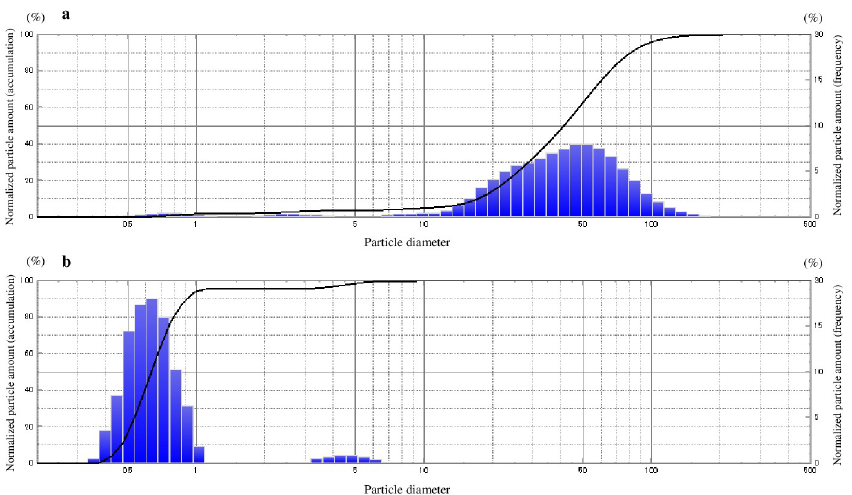
Fig 2. Measurement of n-LAB and d-LAB using a laser diffraction particle size analyzer (SALD-2300). n-LAB ( a ) and d-LAB ( b ) were suspended in distilled water and the relative particle mass (frequency and integration) was measured using a laser diffraction particle size analyzer. d-LAB, dispersed lactic acid bacteria; n-LAB, non-treated lactic acid bacteria; n = 3.